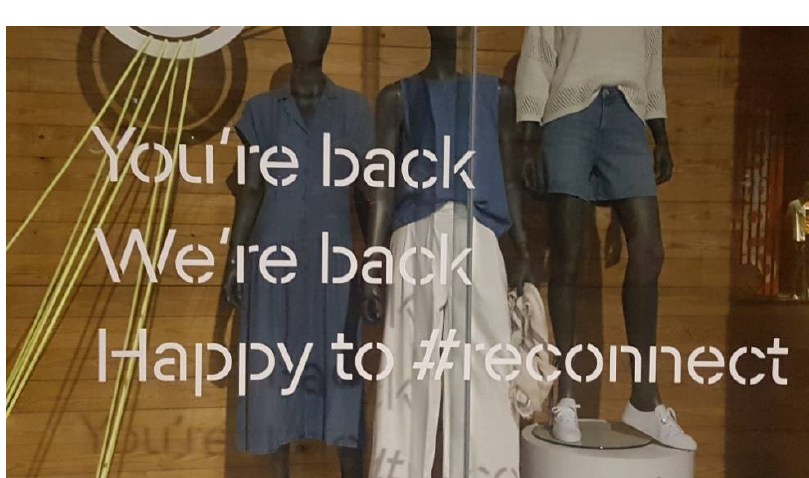
Figure 18. You’re back We’re back Happy to #reconnect.